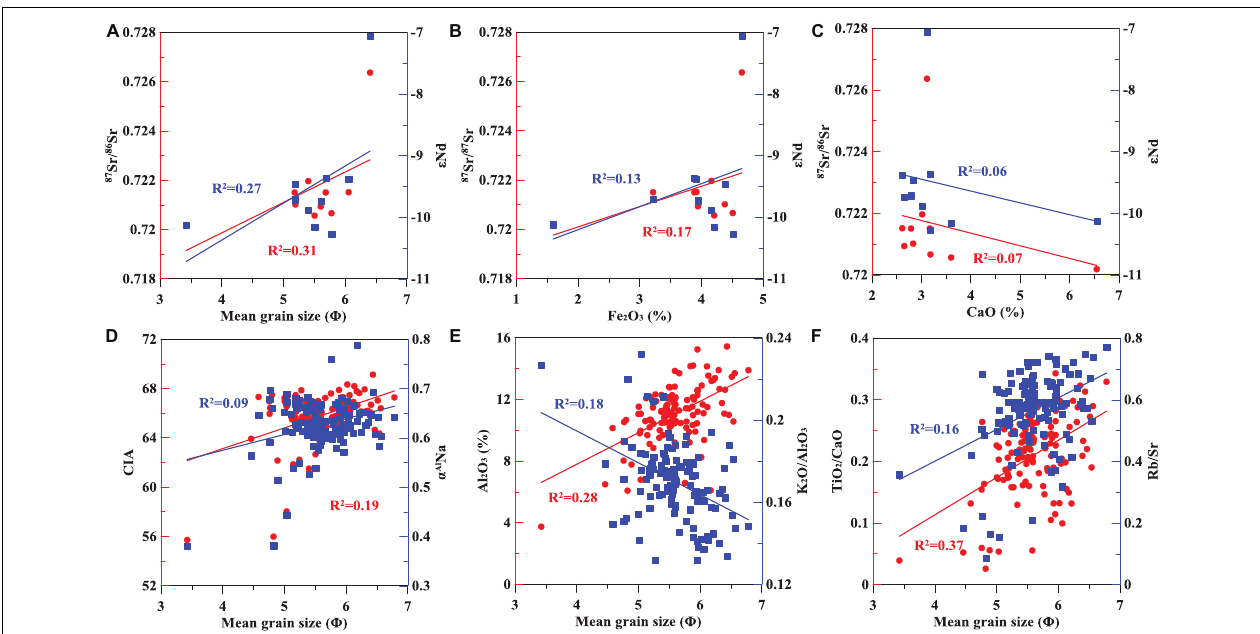
FIGURE 6 | Correlation analysis of Sr-Nd isotopic compositions, mean grain size, Fe 2 O 3 , MnO, and CaO concentrations, and weathering and terrigenous input indicators in Core K17. (A–C ) Correlations between Sr-Nd isotopic compositions and mean grain size, Fe 2 O 3 and CaO concentrations in core K17, respectively. (D–F) Correlations between mean grain size and chemical weathering indicators (CIA, a Al Na and K 2 O/Al 2 O 3 ), and terrigenous input indicators (TiO 2 /CaO and Rb/Sr ratios) in core K17,